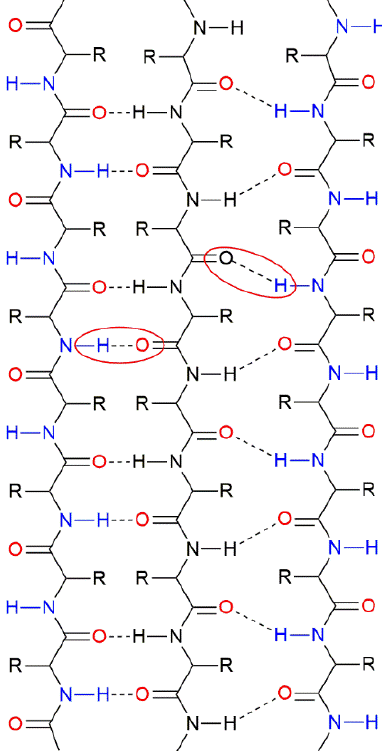
Figure 1. Pleated sheet structure of β-keratin.